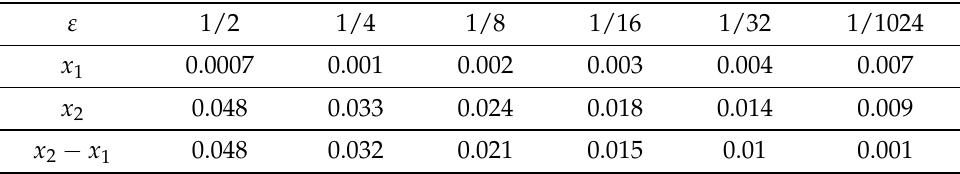
Table 4. Behavior of the interval ( x 1 , x 2 ) depending on ε